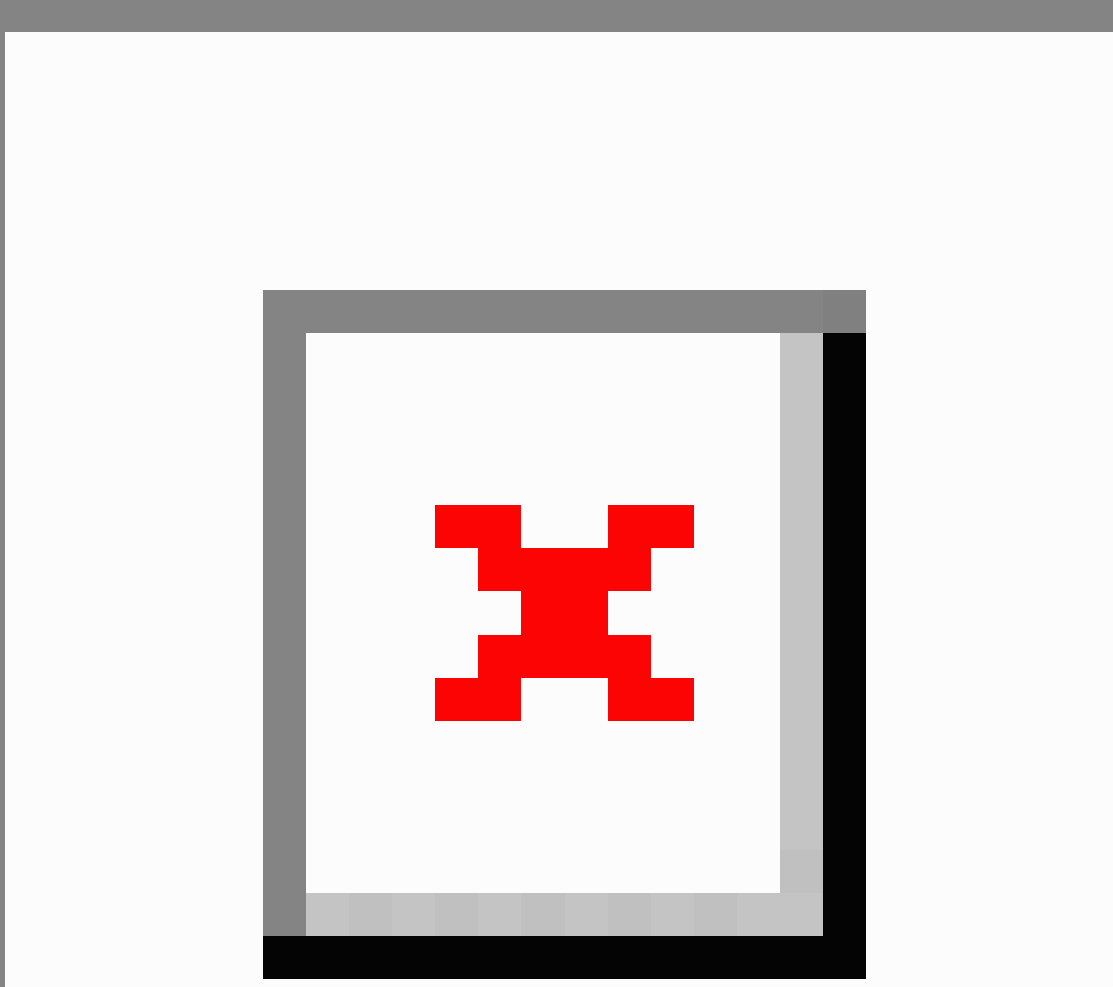
Figure 1. Model layout of the motion-based technology for persons with dementia training at home (Welfare Denmark